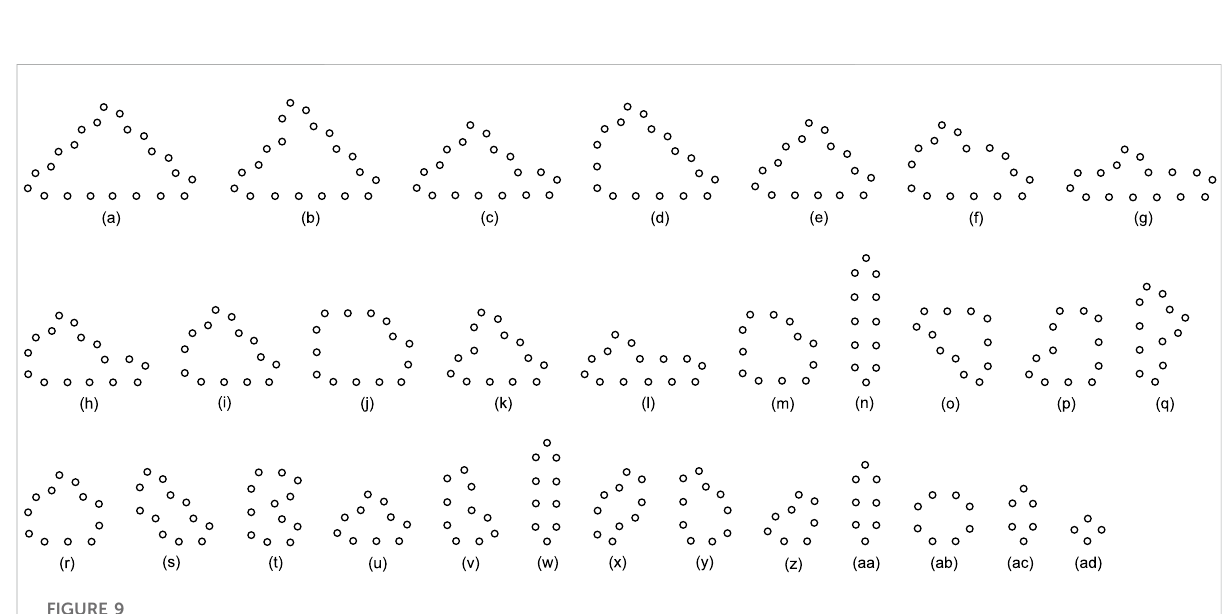
FIGURE 9 All fi nal loop structures starting from the con fi guration in Figure 7B by the greedy selection, adding, and changing mechanisms.